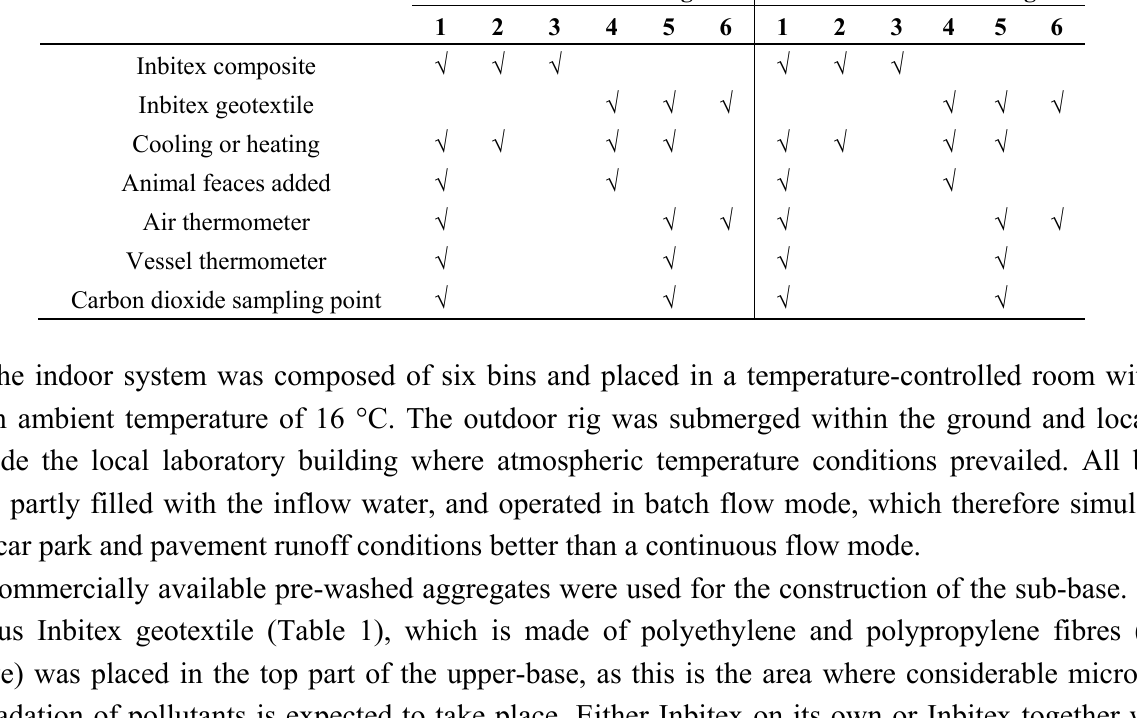
Table 1. Schematic layout of the experimental rigs of the Edinburgh study.